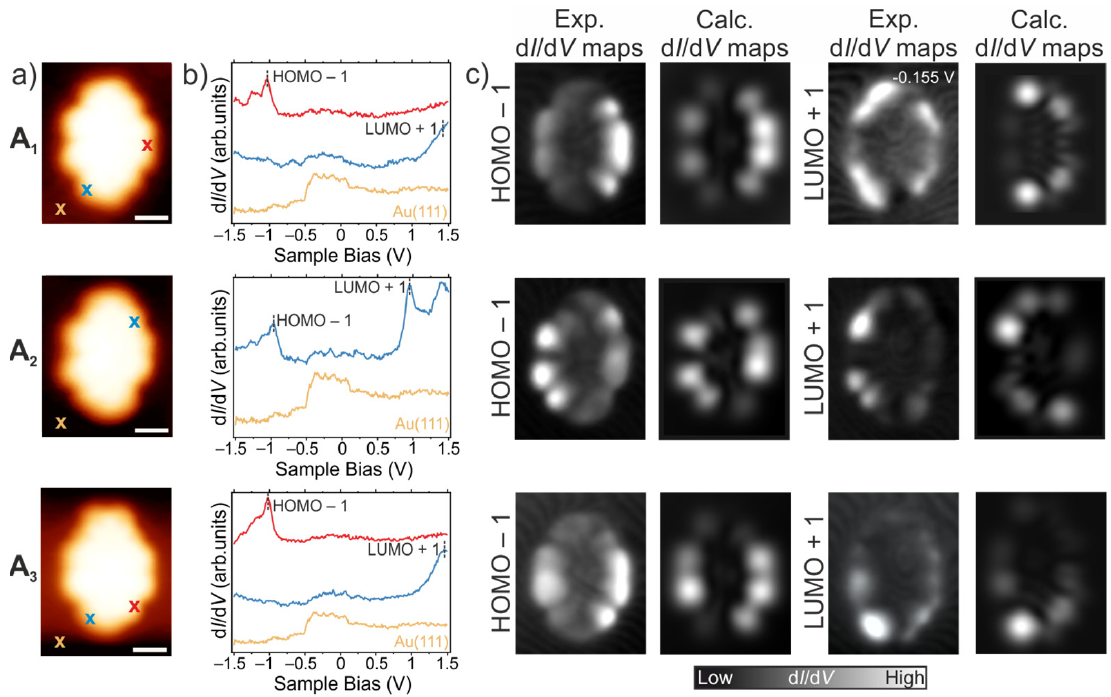
Figure 2. Electronic characterization of A 1 – A 3 on Au(111). ( a ) High-resolution STM images acquired with a CO-functionalized tip displaying the NGs marked with colored squares in ( a ). Scanning parameters: V b = − 1.5 V, I t = 100 pA, all scale bars = 0.5 nm. ( b ) d I /d V spectra of A 1 – A 3 acquired at the positions indicated by the blue and red crosses in ( b ). Reference spectra taken on the bare Au(111) surface is depicted in orange and the acquisition positions marked with an orange cross. Open feed- back parameters for d I /d V spectra: V b = − 1.5 V, I t = 250 pA, V rms = 10 mV. ( c ) Constant-current differ- ential conductance (d I /d V ) maps and corresponding DFT-calculated maps acquired with a CO-tip of the free-standing NGs (tip-sample height = 5 Å) at the energetic positions corresponding to the HOMO − 1 (left) and the LUMO + 1 (right). Scanning parameters: A 1 ; V b = − 980 mV, I t = 300 pA (HOMO − 1), V b = 1400 mV, I t = 300 pA (LUMO + 1). A 2 ; V b = − 980 mV, I t = 250 pA (HOMO − 1), V b =